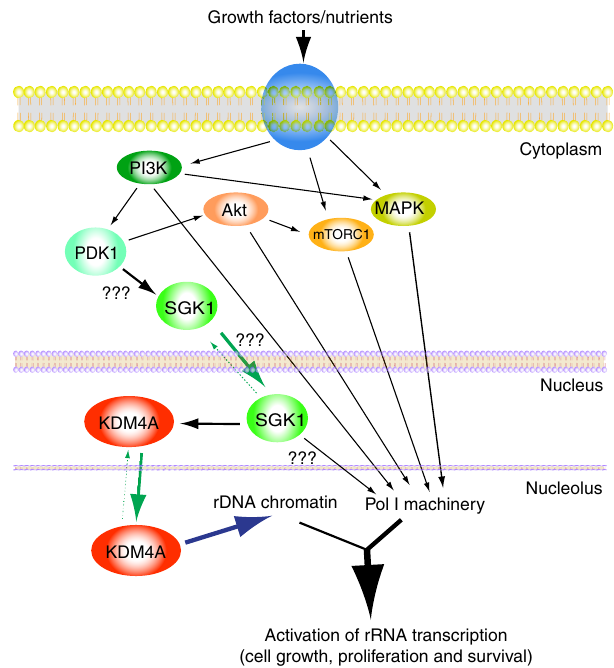
Figure 9 | Schematic outline of serum-induced pathways controlling rDNA transcription. PI3K–Akt, mTOR and MAPK pathways regulate rRNA gene transcription by targeting RNA Polymerase I machinery (as previously published, see Discussion). PI3K–PDK1–SGK1 signalling cascade regulates activation of rRNA gene transcription by controlling histone modifications at rDNA loci through KDM4A localization. SGK1 may in addition target Pol-I transcription machinery independently of